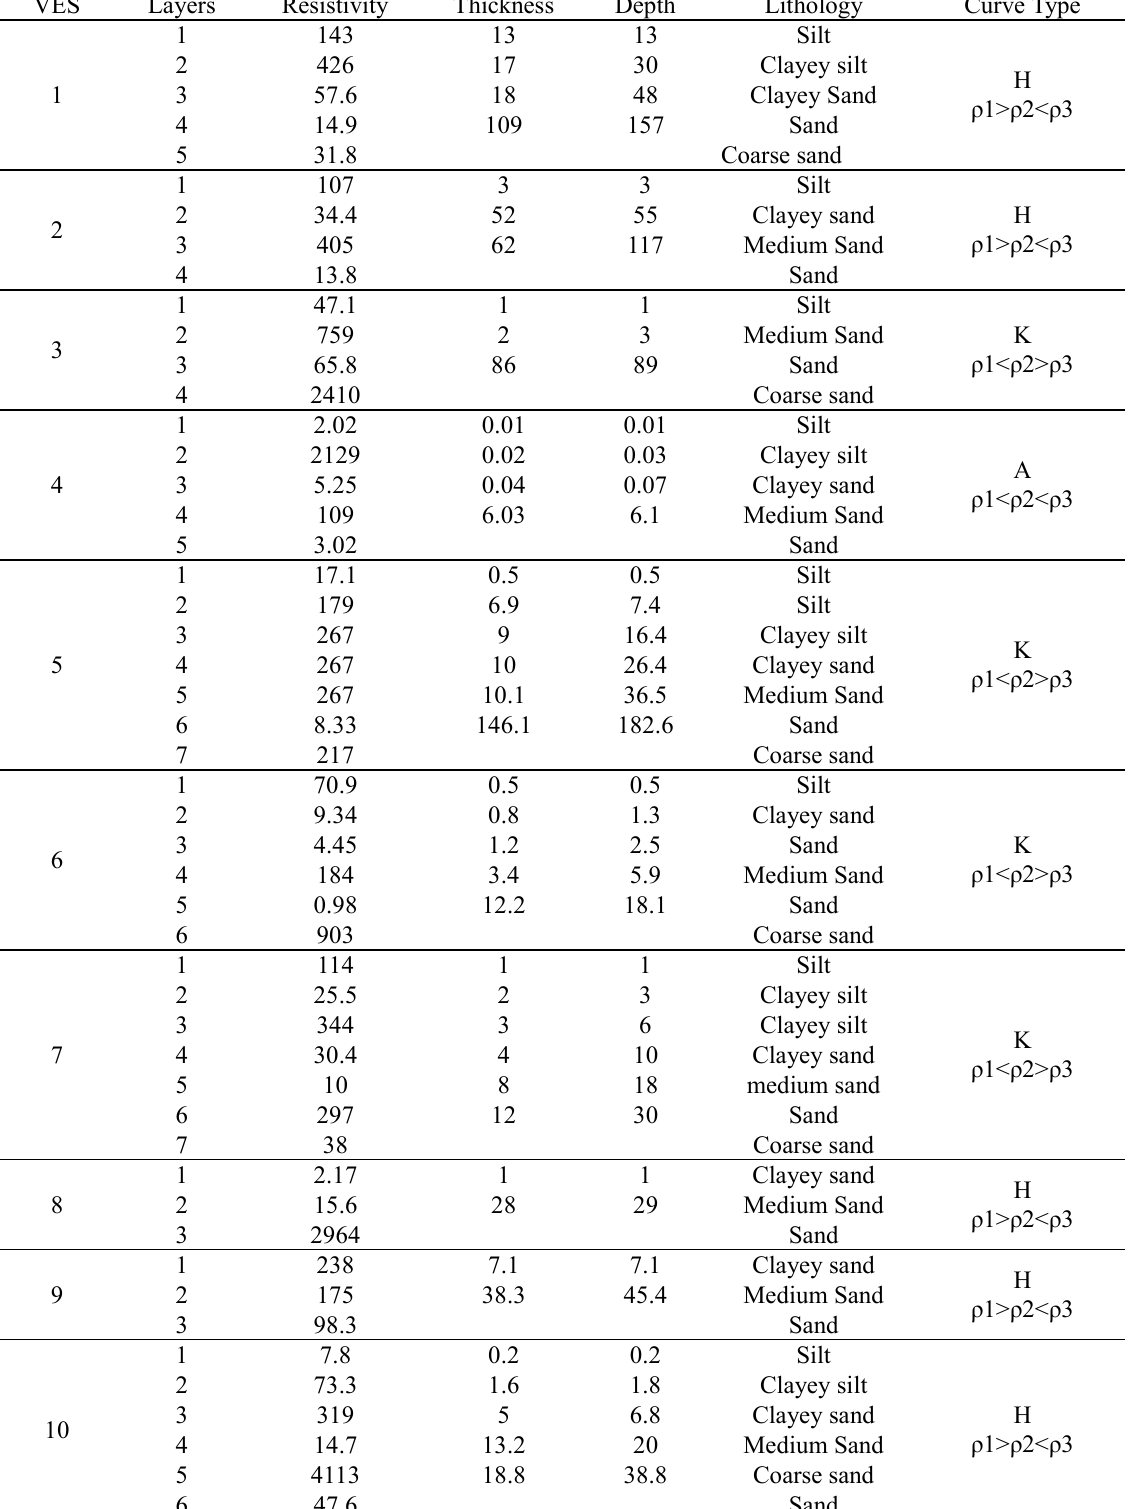
Table 2 Geoelectric parameters and lithology delineation at Alluvial Floodplain of River Dadin Kowa. VES Layers Resistivity Thickness Depth Lithology Curve